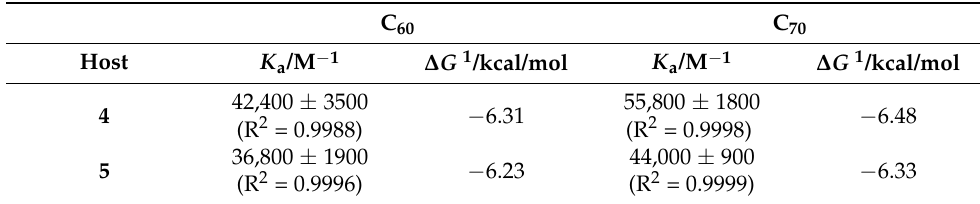
Figure 6. Binding isotherms for the fluorimetric titration of calixarene conjugates 4 ( a , b ) and 5 ( c , d ) with fullerene C 60 and C 70 . Table 2 gathers the corresponding association constants and the estimated free energy of complexation ( G ) associated with the binding event. Table 2. Association constants ( K a ) and free energy changes ( G ) for complex formation with fullerenes.